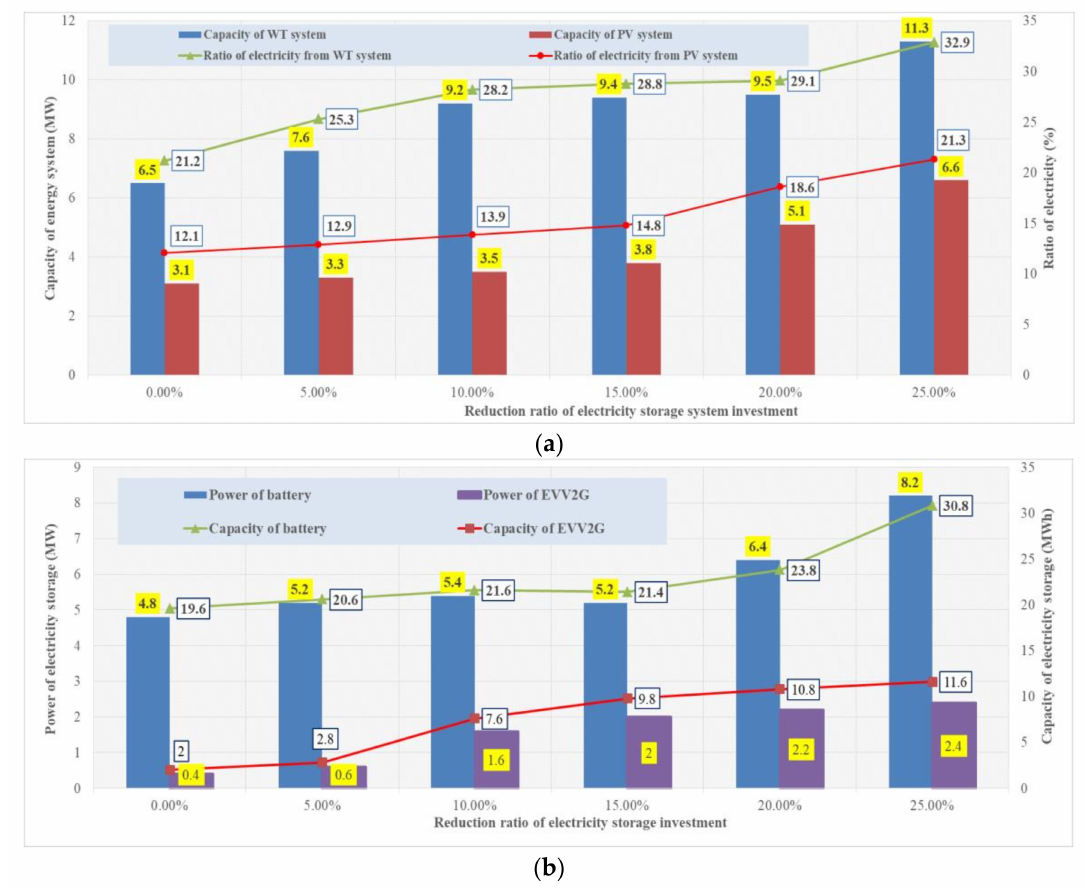
Figure 3. Parametric study for investment reduction of electricity storage system. Variations on solar/wind power system and ESSs with reducing investment of electricity storage system. ( a ) Size variation of WT and PV system; ( b ) Size variation of electricity storage